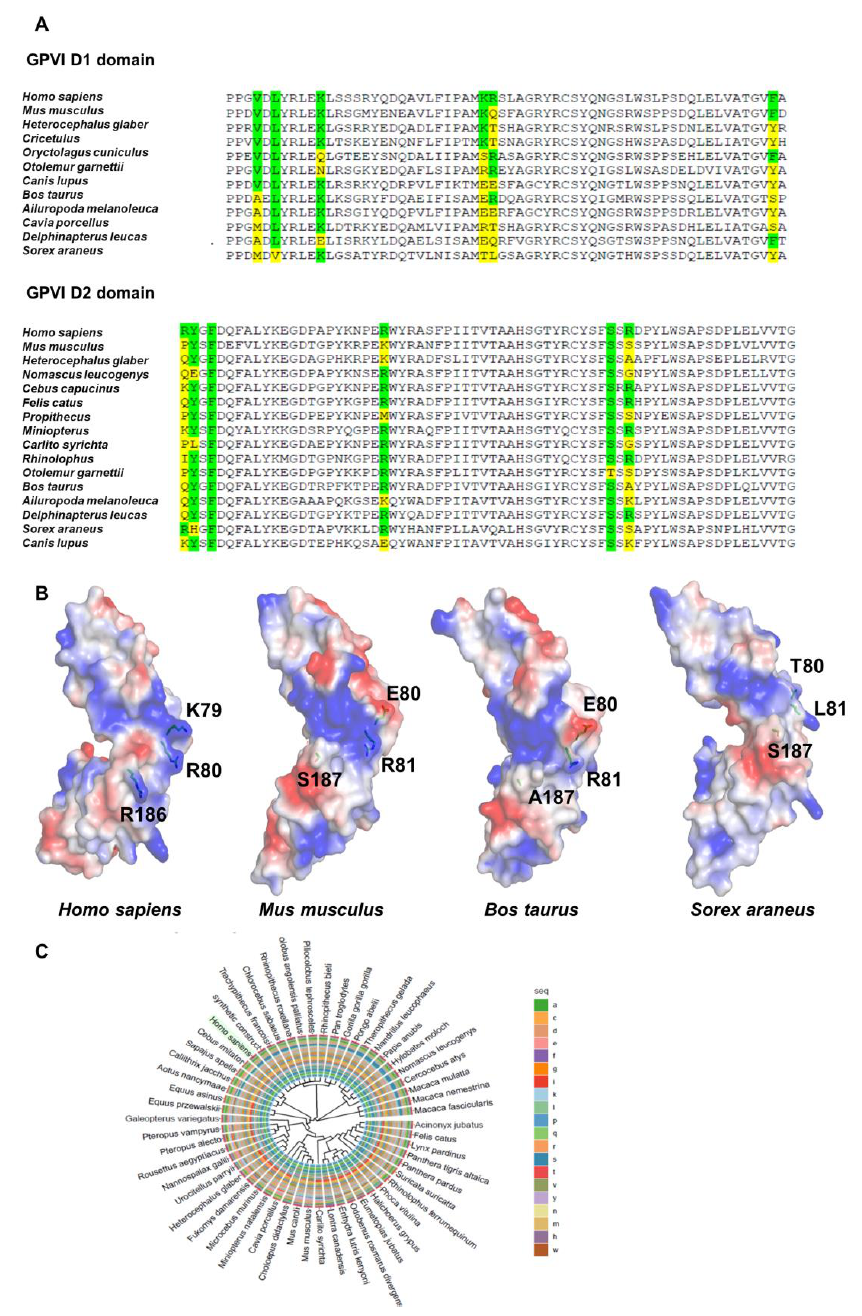
Figure 1. Conserved regions of GPVI in mammalian species. ( A ) The multiple sequence alignment of mammalian GPVI. D1/D2 domain of human GPVI was compared to other mammalians. The conserved amino acid residues involved in collagen- and CRP-binding are indicated in green. The amino acid residues involved in collagen- and CRP-binding which are not fully conserved between mammalian species are indicated in yellow. ( B ) 3D homology models for Homo sapiens , Mus musculus , Bos Taurus, and Sorex araneus . The conserved amino acid residues of human ( Homo sapiens K79, R80, and R186) and mouse GPVI ( Mus musculus E80, R81, and S187) are shown as sticks; those of bovine ( Bos Taurus E80, R81, and A187) and sorex GPVI ( Sorex araneus T80, L81, and S187) are highlighted in cyan and orange, respectively. Electrostatic surface potentials are shown in red and blue for negative and positive charges, respectively, and white for neutral residues. ( C ) The neighbor joining tree of the GPVI D1 domain indicating the phylogenetic relationship between mammalian GPVI